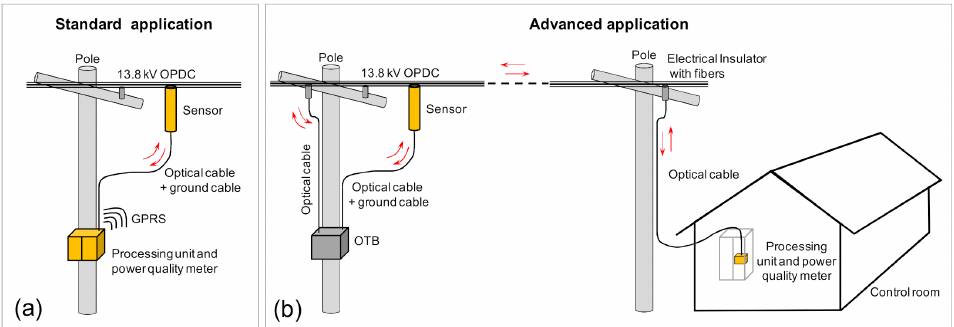
Figure 12. The two applications that were tested in the field for the sensing system. ( a ) Standard application and ( b ) advanced